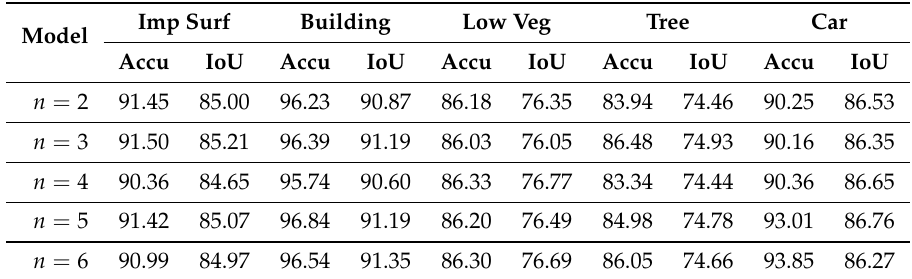
Table 5. Performance of the gate function with different polynomial orders in the L-GCNN. Here, segmentation accuracy and IoU scores (%) reported for comparison. None of the augmented multiscale samples was employed for training.